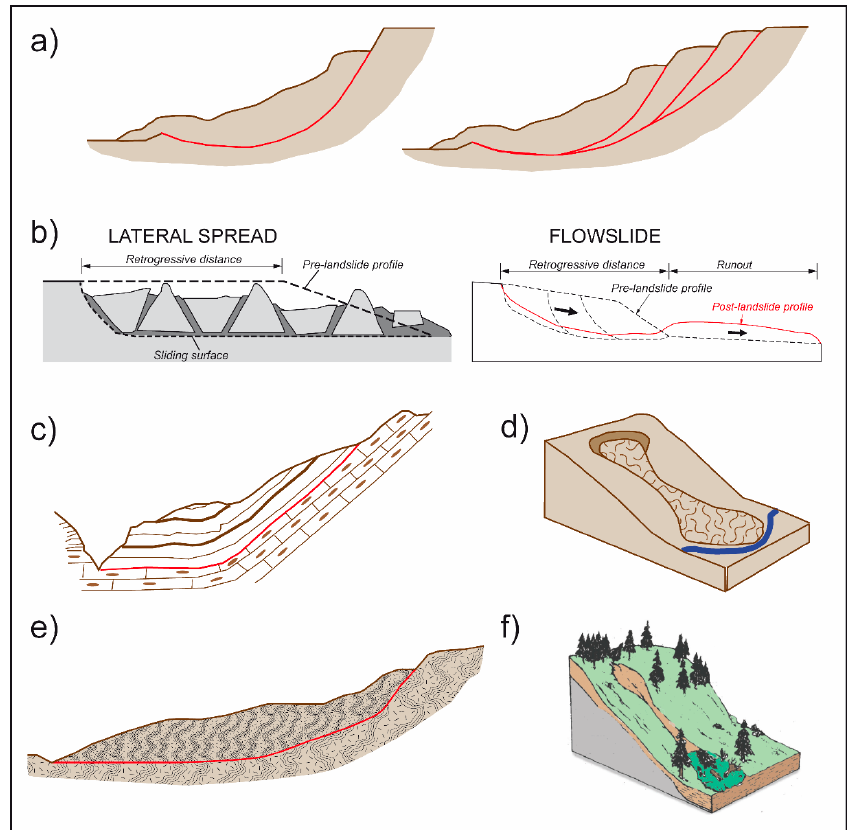
Figure 11. Classes of landslide mechanisms discussed in the paper. ( a ) Rotational-rototranslational slide; ( b ) Lateral spread and flowslide; ( c ) compound landslide; ( d ) earthflow; ( e ) deep mixtilinear slide; ( f ) debris flow and debris flowslide.